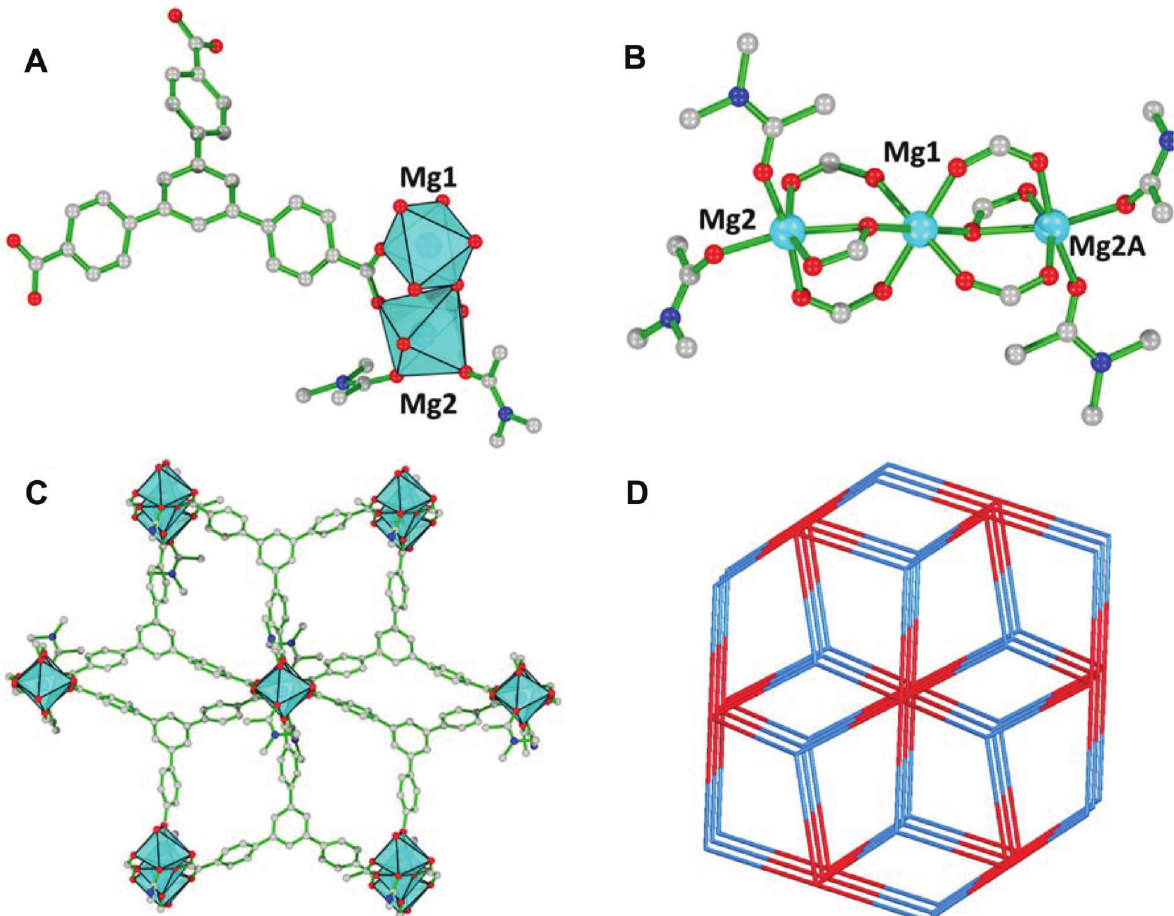
Figure 2. A , View of the asymmetric unit of 1 ; B , view of the [Mg 3 (COO) 6 ] subunit of 1 (symmetry code A: 2-X, 1-Y, 2-Z); C , view of the 2D bi-layered structure of 1 ; D , the binodal (3, 6)-connected kgd network for 1